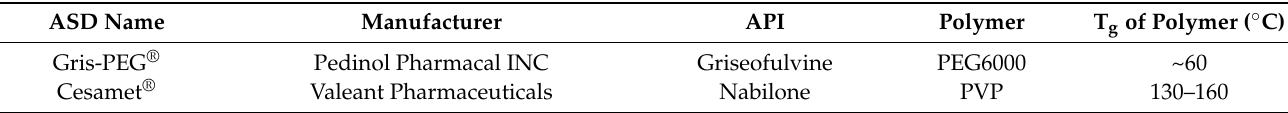
Table 1. Overview of commercially available amorphous solid dispersions (ASDs), their manufacturer, active pharmaceutical ingredient (API), the polymer used to produce the ASDs, and the glass transition temperature (T g ) in Celsius (°C) of the polymer. Ref. [86,94].